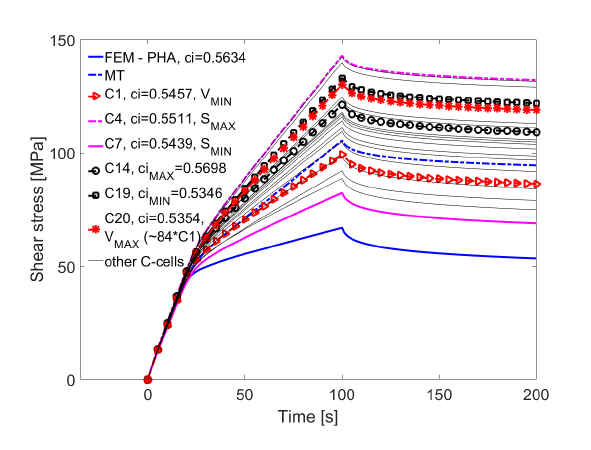
Figure 8. Time evolution of shear stress for carbon composites.